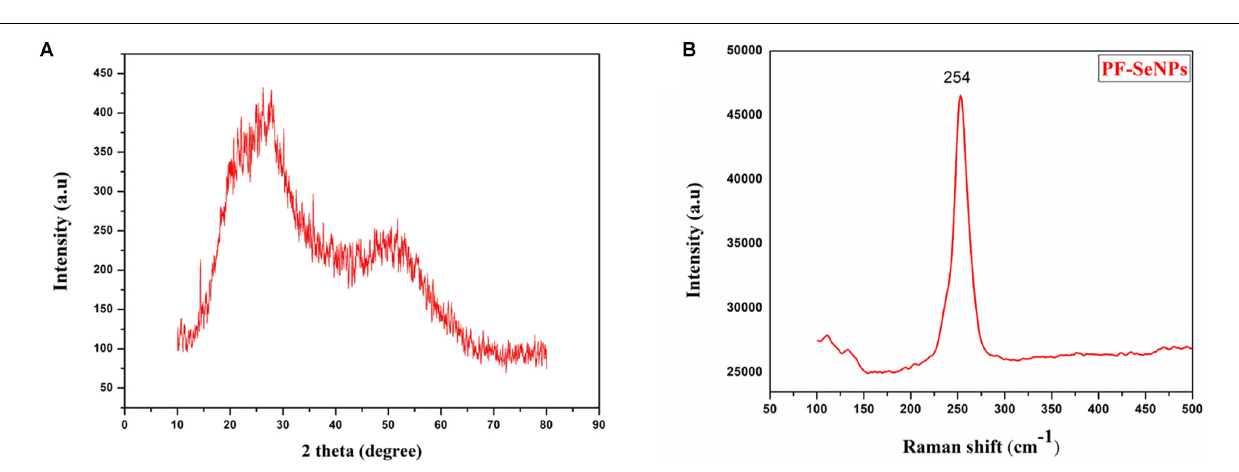
FIGURE 4 | (A) X-ray diffraction (XRD) pattern and (B) Raman spectroscopy of phytofabricated selenium nanoparticles